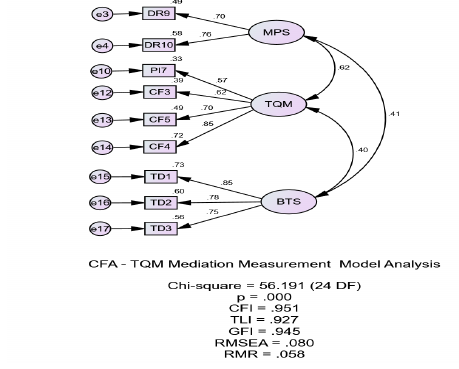
Fig. 2. CFA-TQM mediation measurement model analysis (Factor loadings)